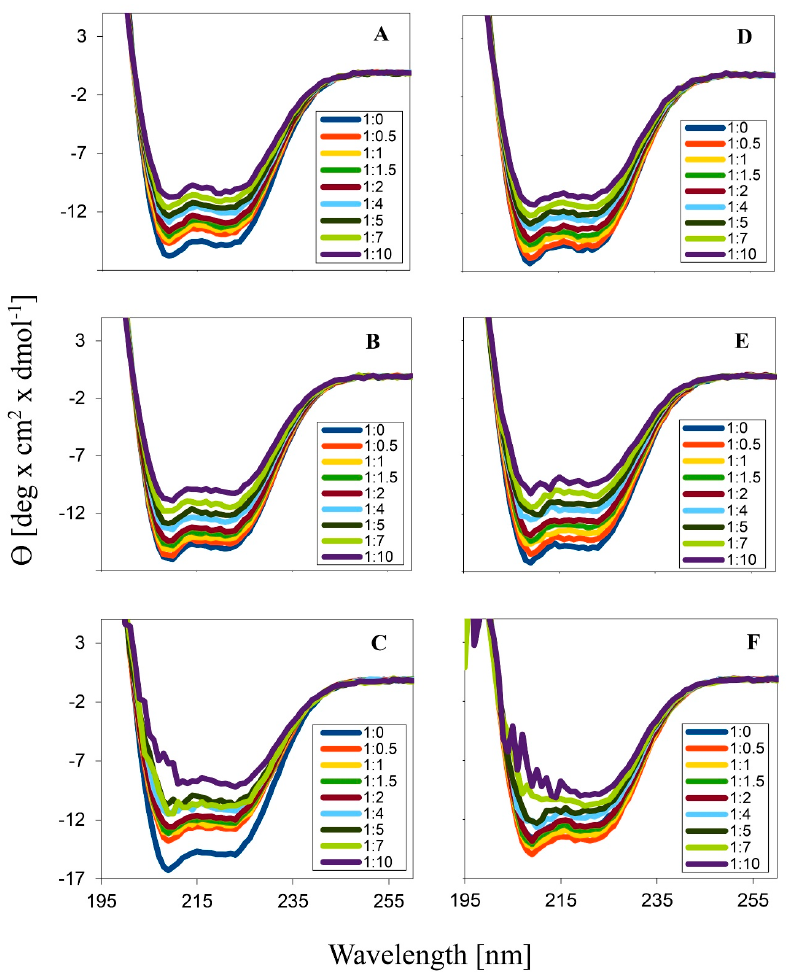
Figure 3. The CD spectra of human serum albumin (HSA) in the presence of copper metallodendrimers: ( A ) CCD-NO-0, ( B ) CCD-NO-1, ( C ) CCD-NO-2, ( D ) CCD-Cl-0, ( E ) CCD-Cl-1, ( F ) CCD-Cl-2. HSA concentration 0.25 µ mol / L, wavelength 195–260 nm, scan speed 50 nm / min, bandwidth 1.0 nm,